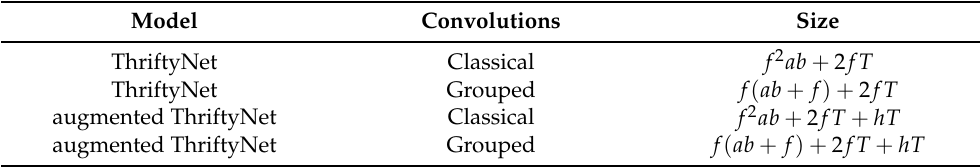
Table 1. Summary of the number of parameters of the proposed models, as functions of the hyperpa-